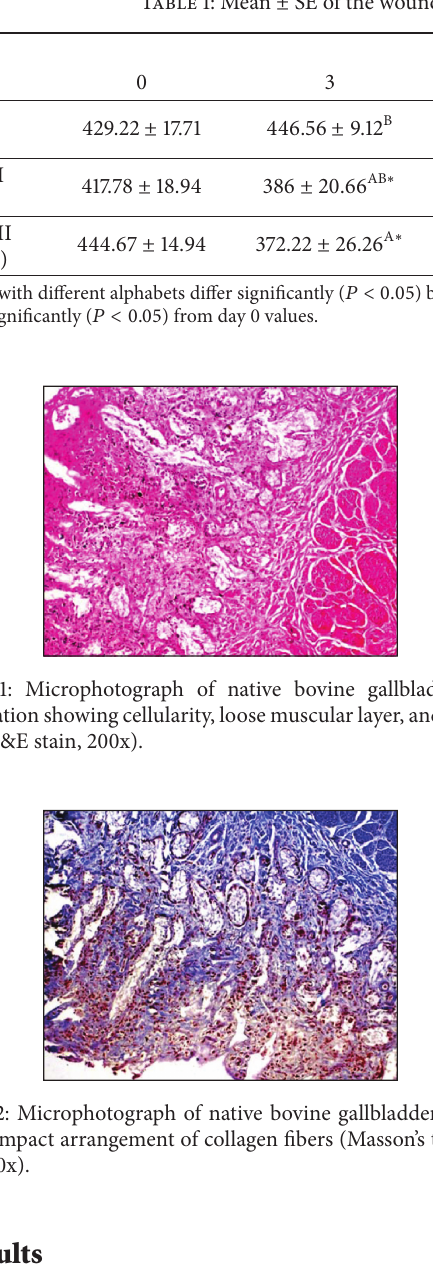
Table 1: Mean ± SE of the wound area (mm 2 ) at different time intervals in various groups.